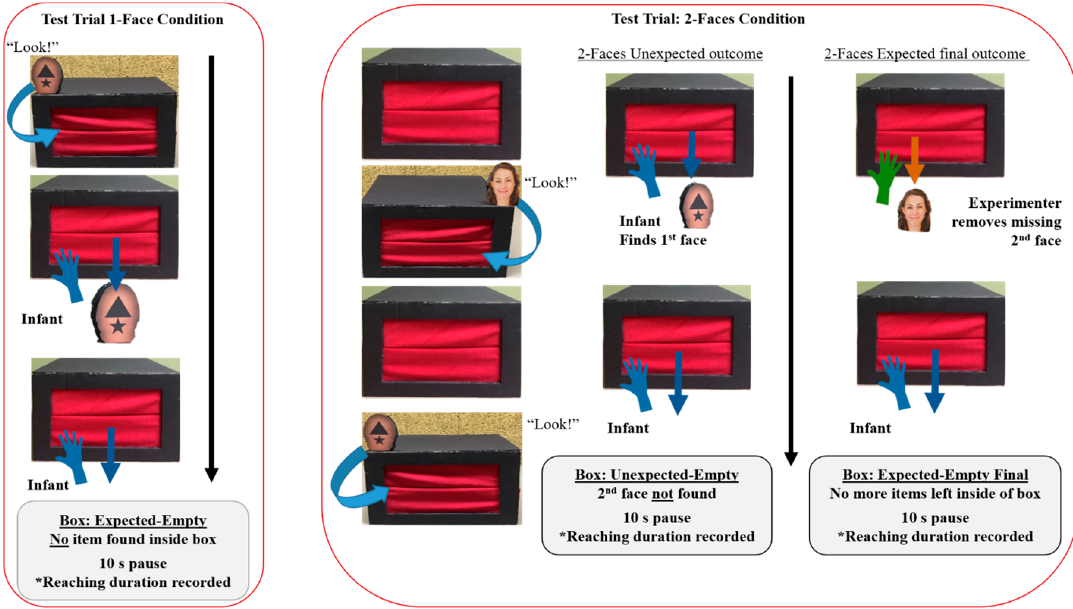
Figure 2. Manual search box task. Infants completed 8 trials, 4 trials per face block. There were three types of face outcomes. The image on the left depicts the expected-empty trial. Such that infants saw one face go in and only found one face within the box. The image on the right depicts the unexpected-empty and expected-empty-final trials. Unexpected-empty trials included infants seeing two faces go inside of the box but only finding one face. Expected-empty-final trials followed unexpected-empty trials. Infants were presented with the second face, leaving the box completely empty.